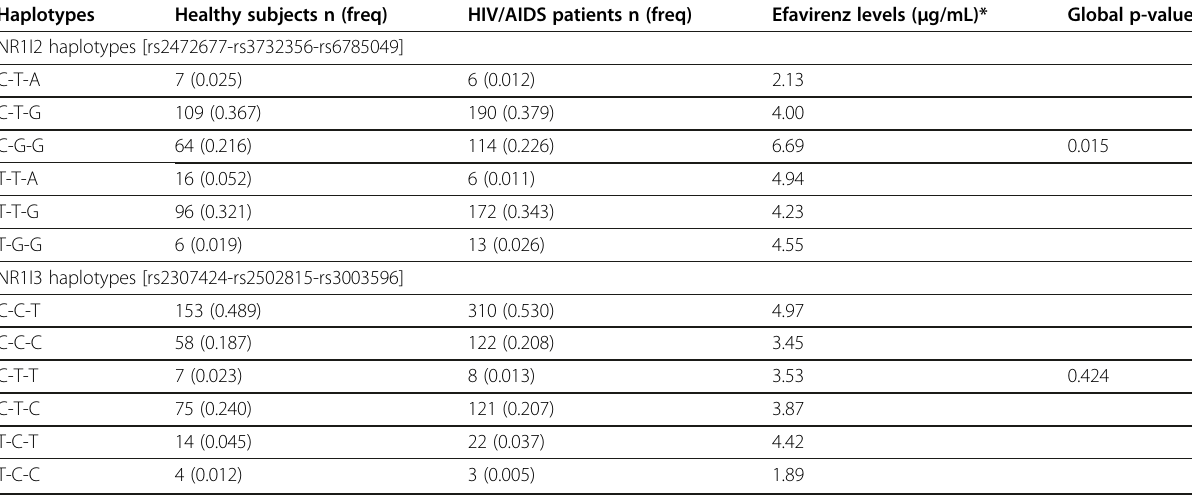
Table 6 Comparison of the haplotype frequencies between the healthy subjects and the HIV/AIDS patients Haplotypes